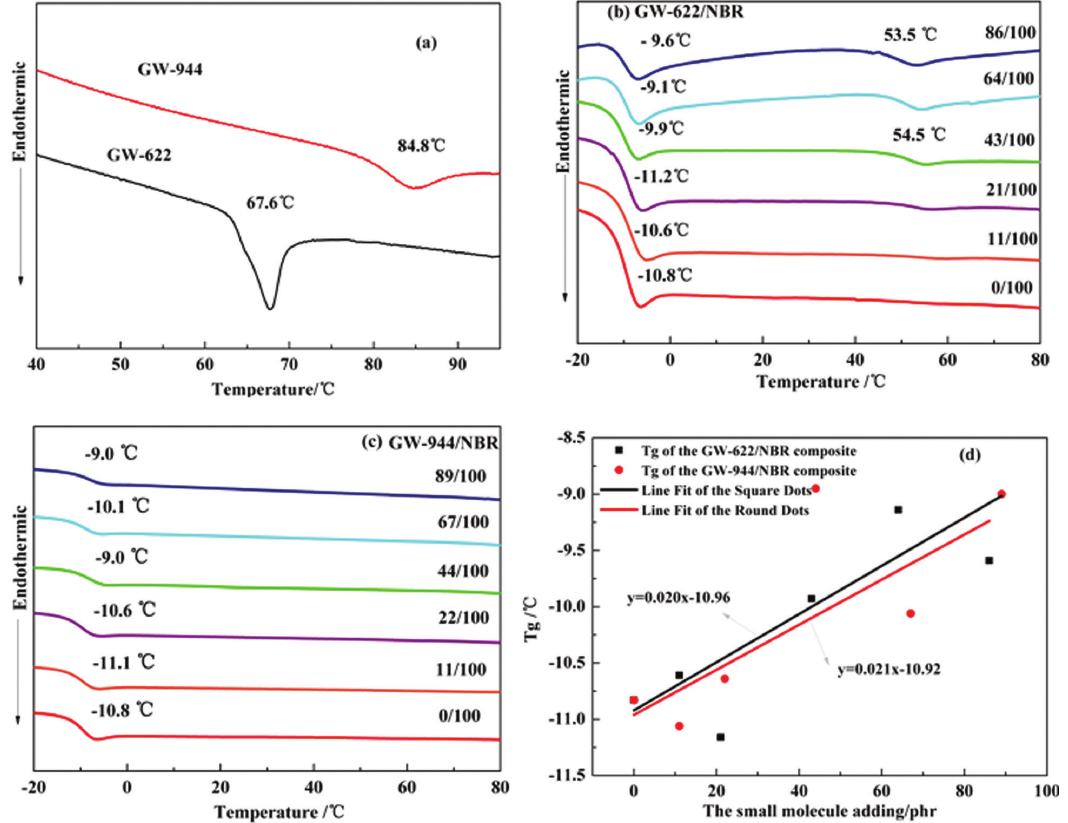
Figure 4: DSC thermograms of (a) hindered amines, (b) GW-622/NBR composites and (c) GW-944/NBR composites; (d) the fitting curves of the Tg of different composites.